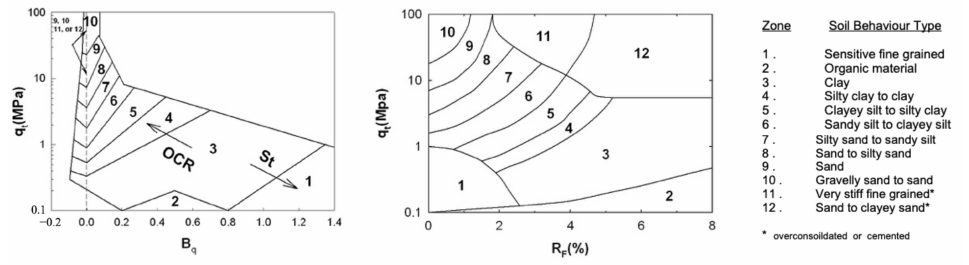
Figure 1. Soil classification charts by Robertson et al. [3].